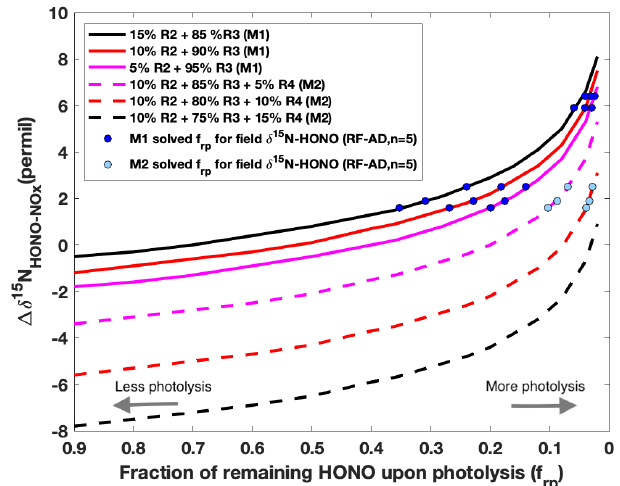
Figure 5. Modeling results of δ 15 N for aged daytime smoke via two plausible mechanisms (M1 and M2) for secondary HONO produc- tion. The isotope mass balance model (Eq. 1) is used to simulate the = δ 15 N − δ 15 N δ 15 N difference ( (cid:49)δ 15 N HONO − NO HONO NO x ) as x a function of the fraction of HONO remaining after photolysis ( f rp ) in a pseudo-photochemical steady state. The calculated kinetic frac- tionation factors used here are explained in Appendix B. In the first mechanism (M1, solid lines), Reaction (R3) is the major HONO production pathway with a varying relative contribution from Reac- tion (R2), which is constrained as producing no more than 15% of the observed HONO concentrations. In the second mechanism (M2, dashed lines), nitrate photolysis (Reaction R4) is included in addi- tion to Reactions (R2) and (R3) for HONO production. Taking the contribution of Reaction (R2) of 10% as a constant, three scenarios were modeled by varying the relative contribution of Reaction (R3) (75%–85%) and (R4)